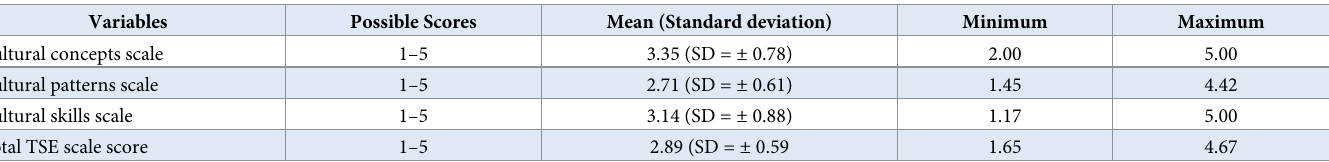
Table 2. Descriptive statistics for each subscale of transcultural self-efficacy and the total TSE scale score of nurses working at JMC, Oromia Region, Ethiopia, May to June 2020 (n = 236).